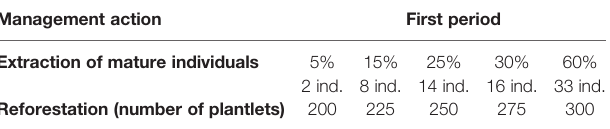
TABLE 3 | Different combinations of thresholds of management actions to maintain l above unity in the population Piedra de Indio during the fi rst monitoring period of the study.